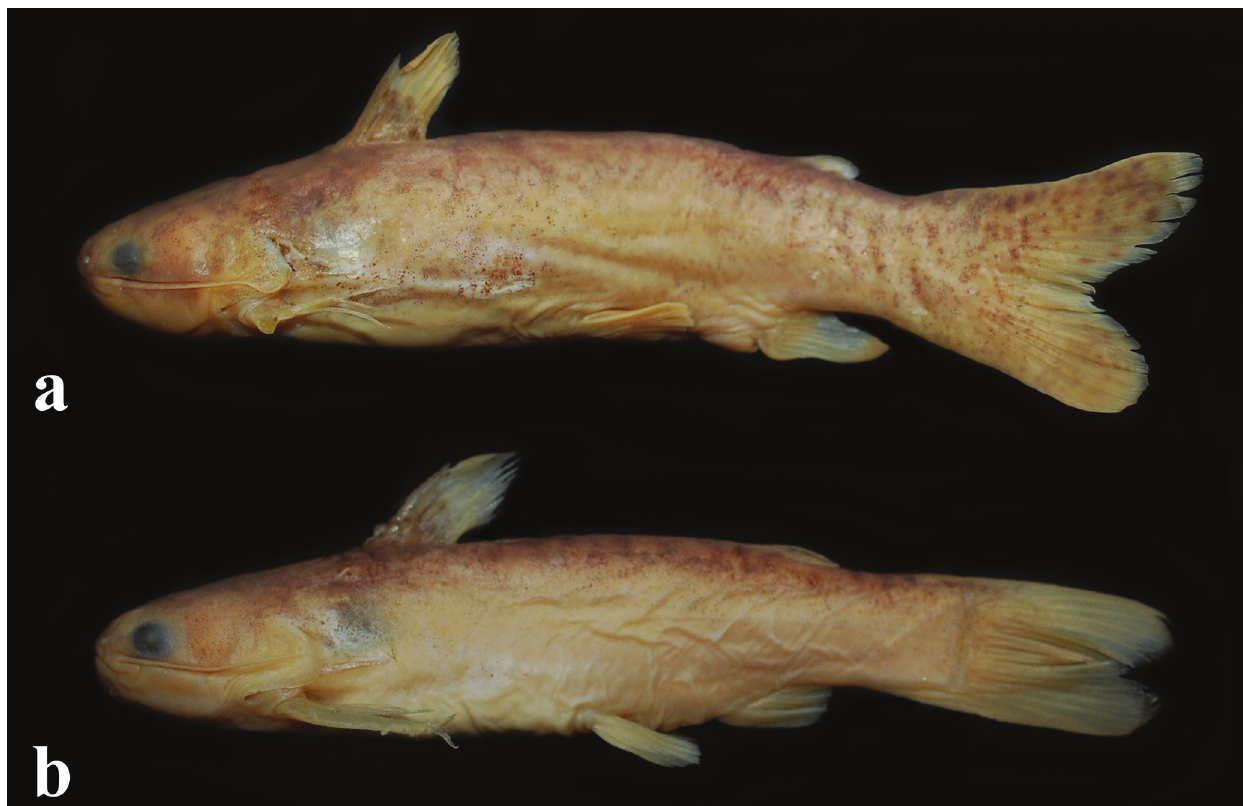
Fig. 1. Glanidium botocudo , new species, ( a ) holotype, MNRJ 32538, male, 93.2 mm SL, rio Mucuri downstream from Santa Clara Dam, Nanuque, Minas Gerais State, Brazil. ( b ) paratype, MBML 2047, female, 86.8 mm SL, rio Doce, on area of influence of Baú I Dam, Santa Cruz do Escalvado, Minas Gerais State,